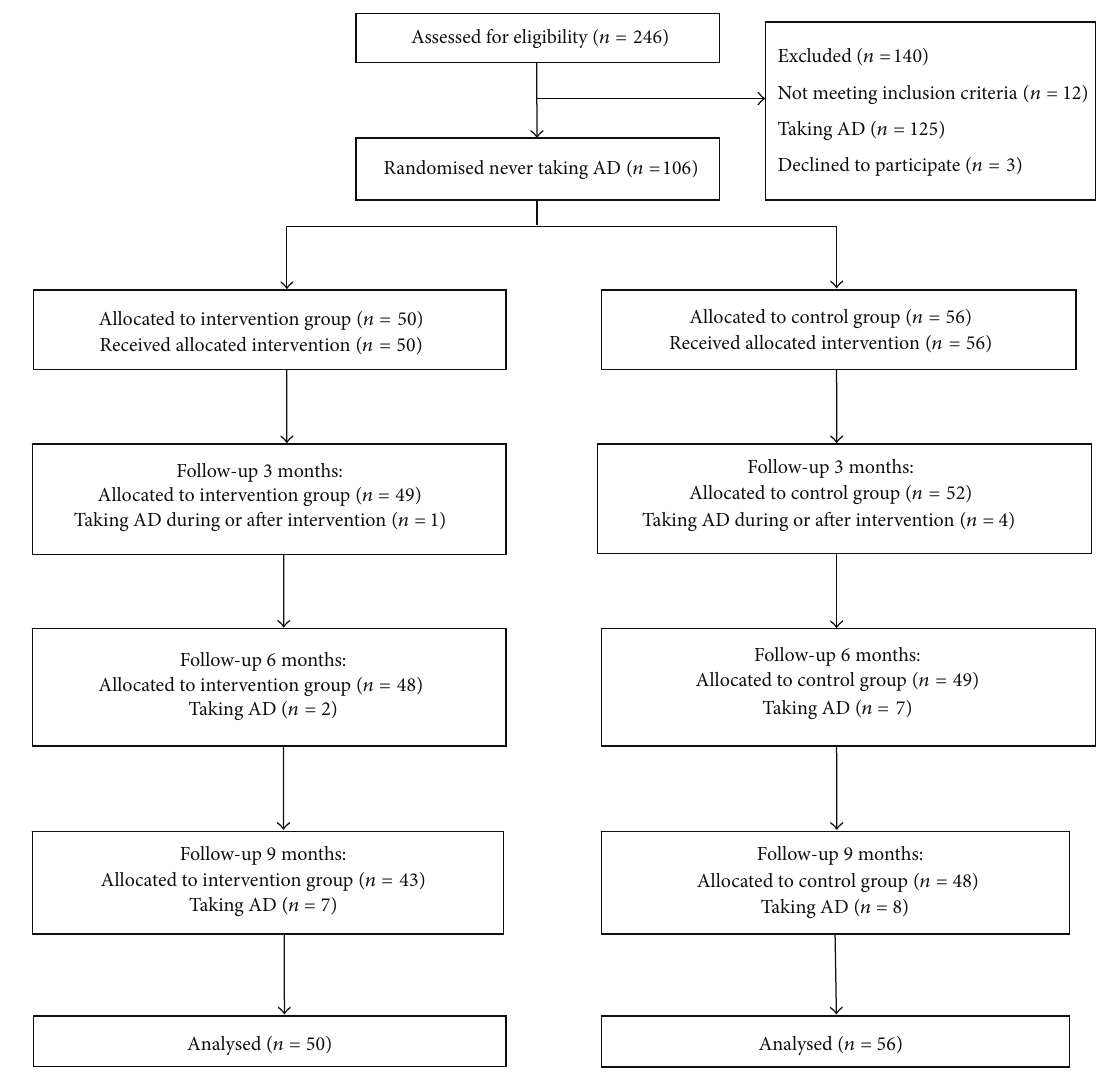
Figure 1: Flow chart of